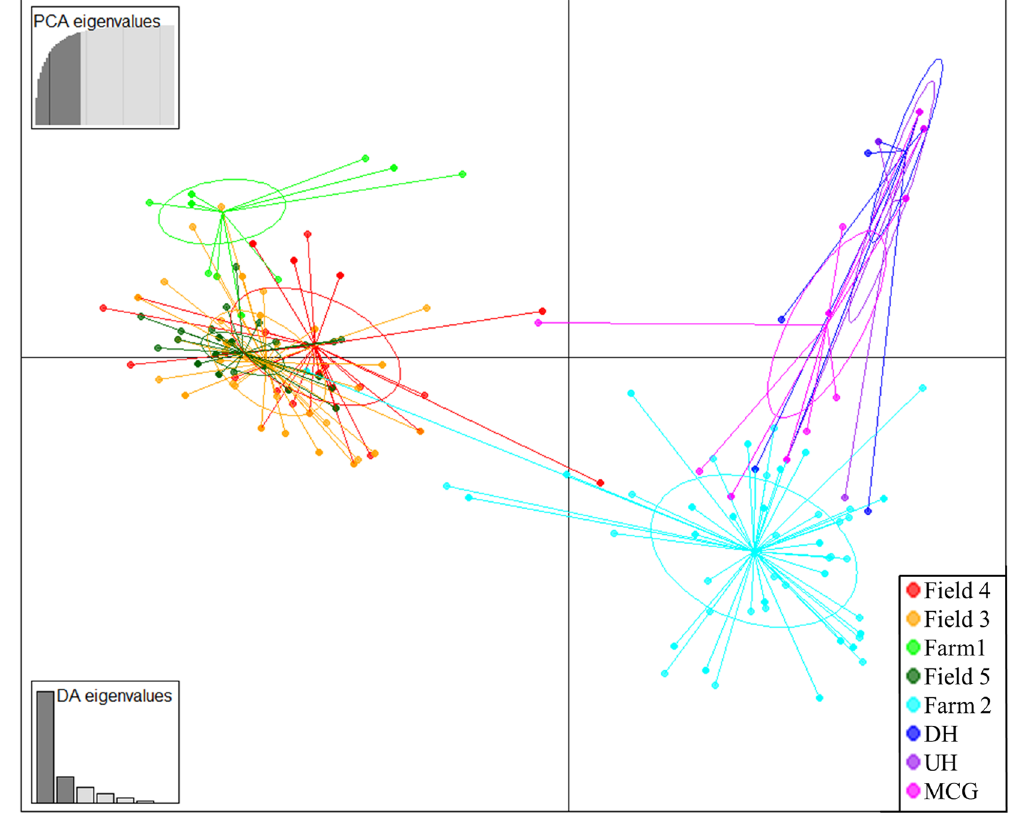
Figure 4. Discriminant Analysis of Principal Components for Cercospora beticola populations from New York (Farm 1, Farm 2, Field 3, Field 4 and Field 5) and Hawaii (MCG = Manoa community garden, UH = University of Hawaii organic garden, and DH = Diamond Head community garden), 2015.